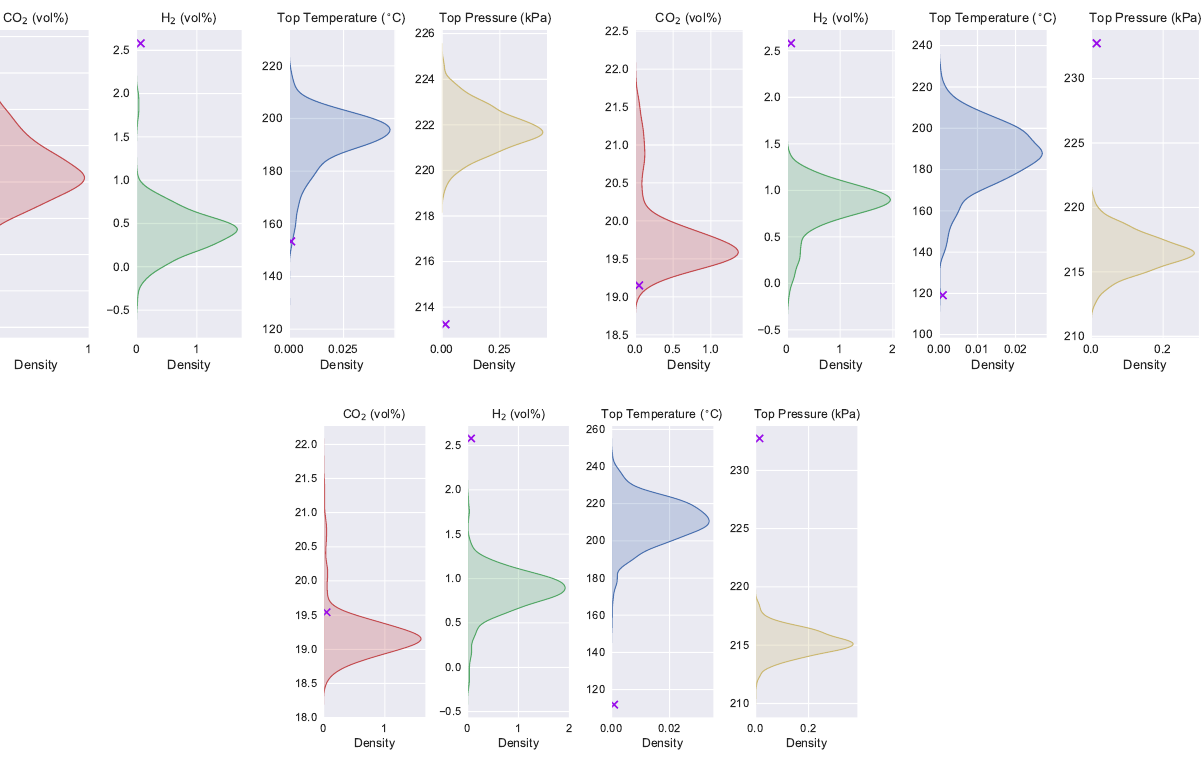
Figure 14. Inconsistency of operating parameters and detection variables recommended by the conventional optimization method.